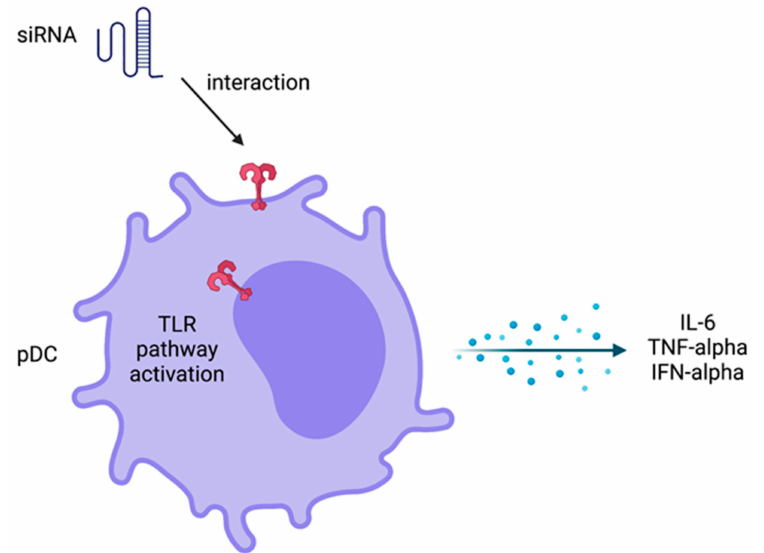
Figure 4. Innate immune response activation by siRNA. There is an interaction among siRNA and plasmacytoid dendritic cells (pDC) upon systemic delivery to induce the cell activation and cytokines production by toll-like receptor (TLR) signaling pathway. Created with